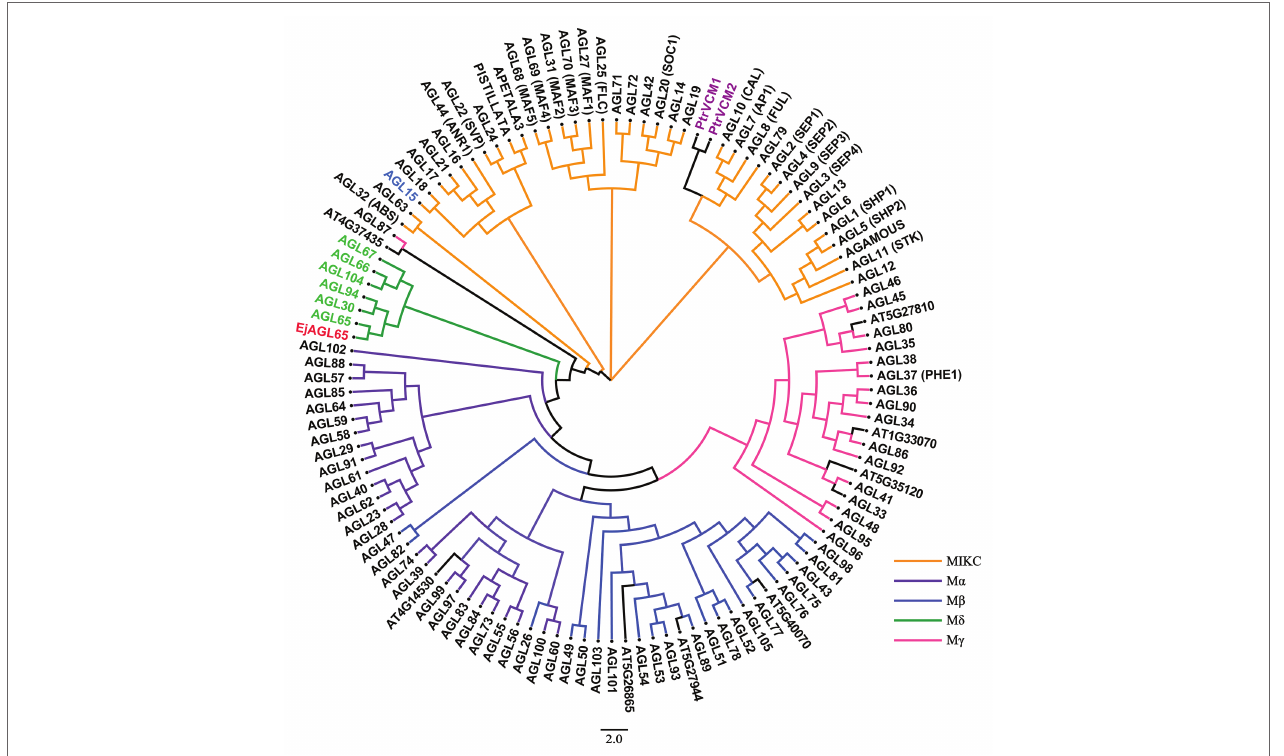
FIGURE 2 | Phylogenetic analysis of EjAGL65 with 116 Arabidopsis MADS-box proteins and two Populus MADS-box proteins. The previously defined M δ group genes are shown in green. EjAGL65 was structurally closest to Arabidopsis AGL65 (At1g18750) and is shown in red. AGL15 (At5g13790), which was expressed in the lignified tissue of Arabidopsis , is shown in blue. PtrVCM1 and PtrVCM2, which affect vascular cambium proliferation activity, are in purple. The color of clades represents MIKC (orange), M α (violet), M β (blue), M δ (green), and M γ (pink) subgroups of Arabidopsis MADS-box genes. Genes without annotations are labeled with an ID from the TAIR